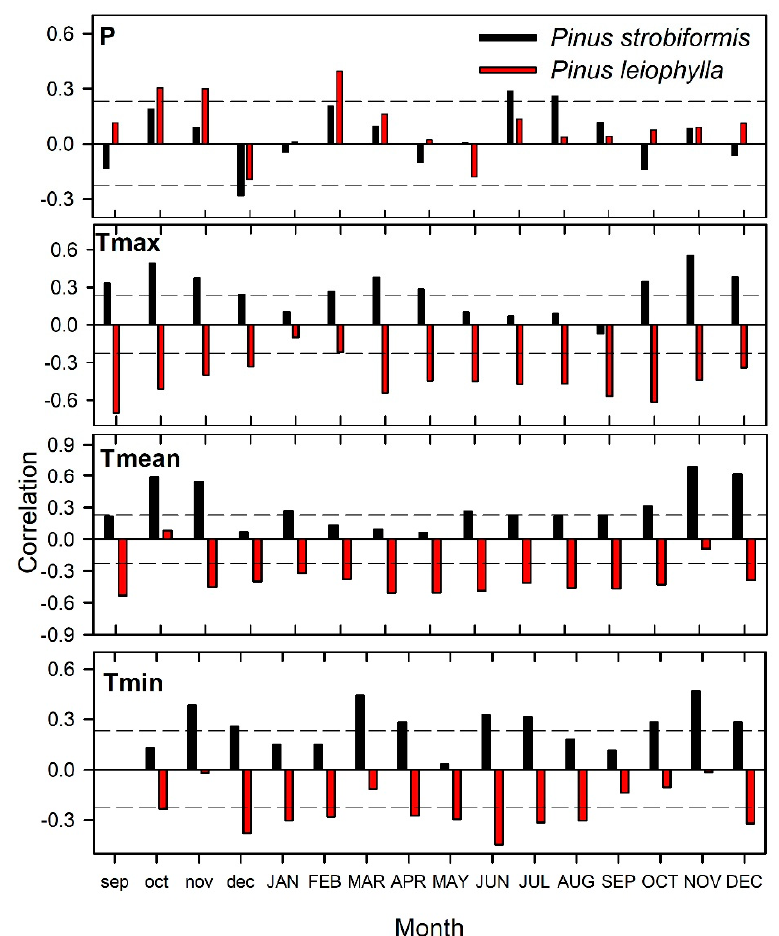
Figure 3. Correlation indexes between carbon accumulation and monthly data of the climatic variables for the two species studied. P = precipitation, Tmax = maximum temperature, Tmean = average temperature, Tmin = minimum temperature. The months in lowercase and uppercase correspond to the months of the previous year and the current year, respectively. The dashed horizontal lines show the p = 0.05 level of significance.